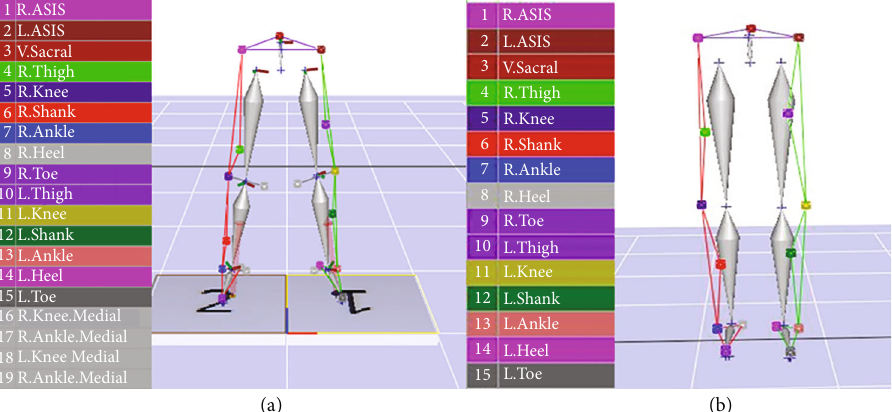
Figure 1: Re fl ective marker attachment. (a) Static posture marker. (b) The four medial markers for movement have been removed.